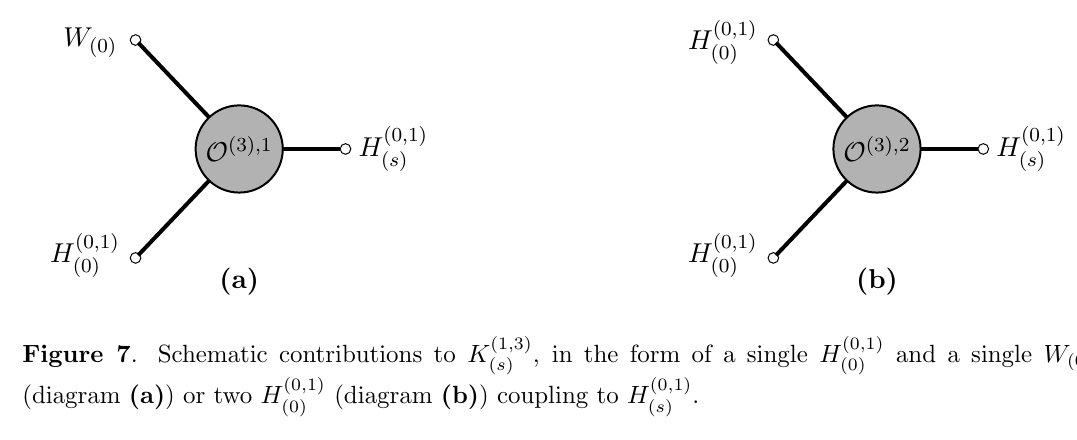
Figure 7 . Schematic contributions to K (1 ; 3) (diagram (a) ) or two H (0 ; 1)